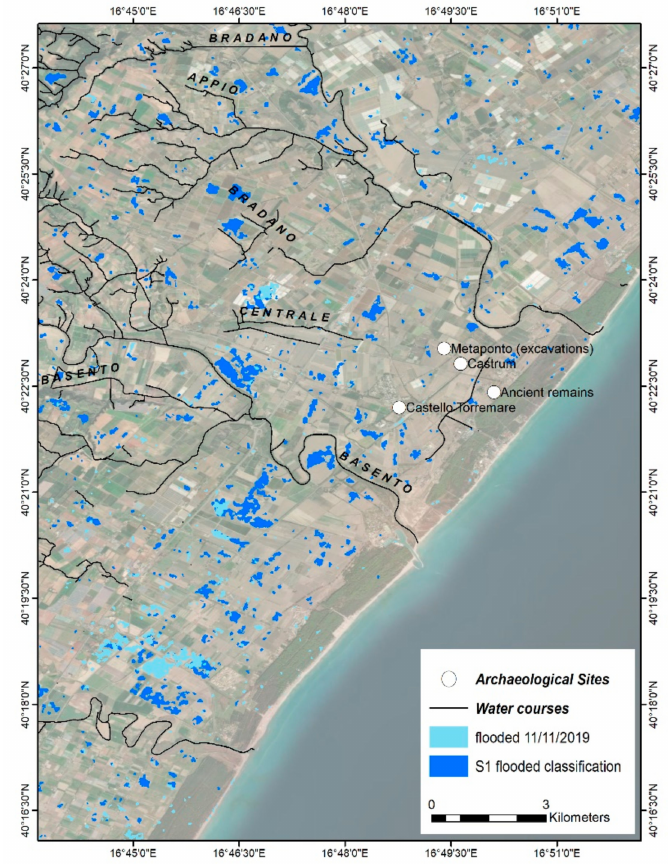
Figure 10. Sentinel-2 NDWI classification on 11 November 2019 (light blue) and Sentinel-1 before- and-after difference classification (dark blue). The image finds a useful comparison in Figure 8 of [65].